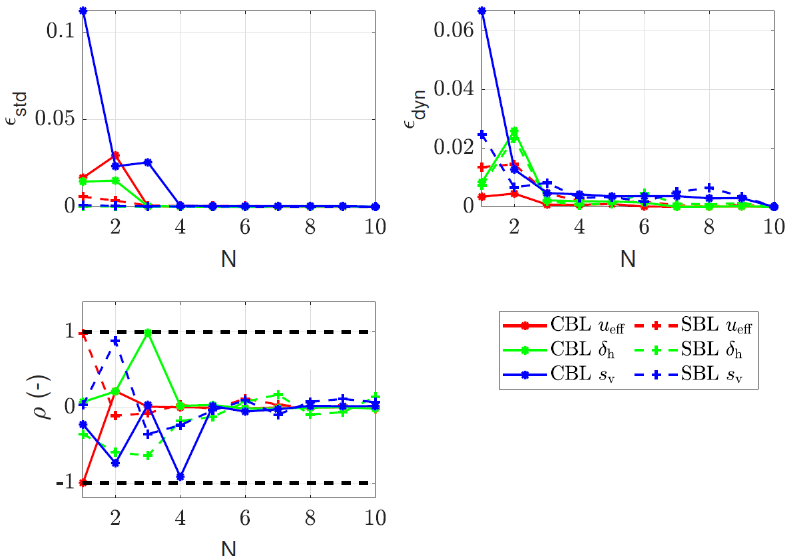
Figure 9. The standard ( (cid:101) std ) and dynamic ( (cid:101) dyn ) errors of the three-parameters calculated for reconstructions with various numbers of modes; correlations ( ρ ) between the time series of the reconstructed three-parameter wind field parameters; and the time evolution of the different POD modes Z j ( t )